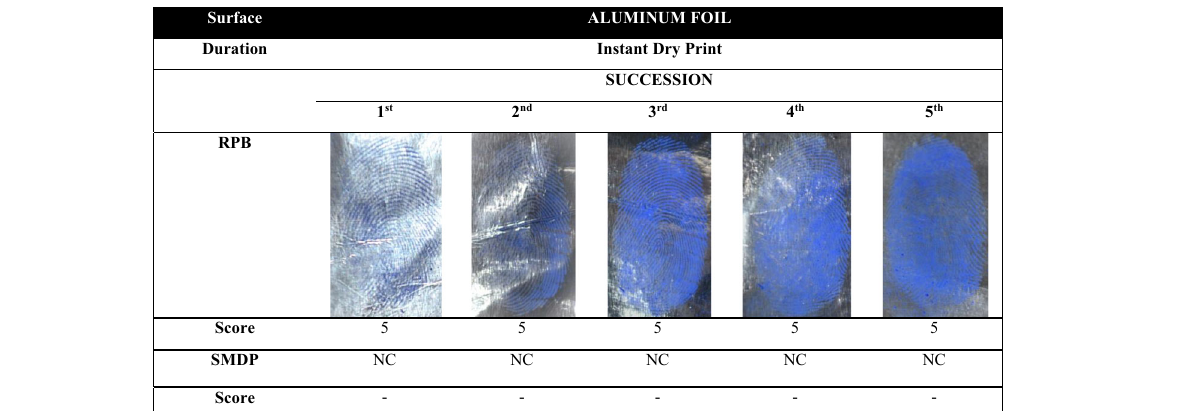
Table 11 Development of successive prints on aluminium foil using Robin powder blue and silver magnetic dual powder Surface ALUMINUM